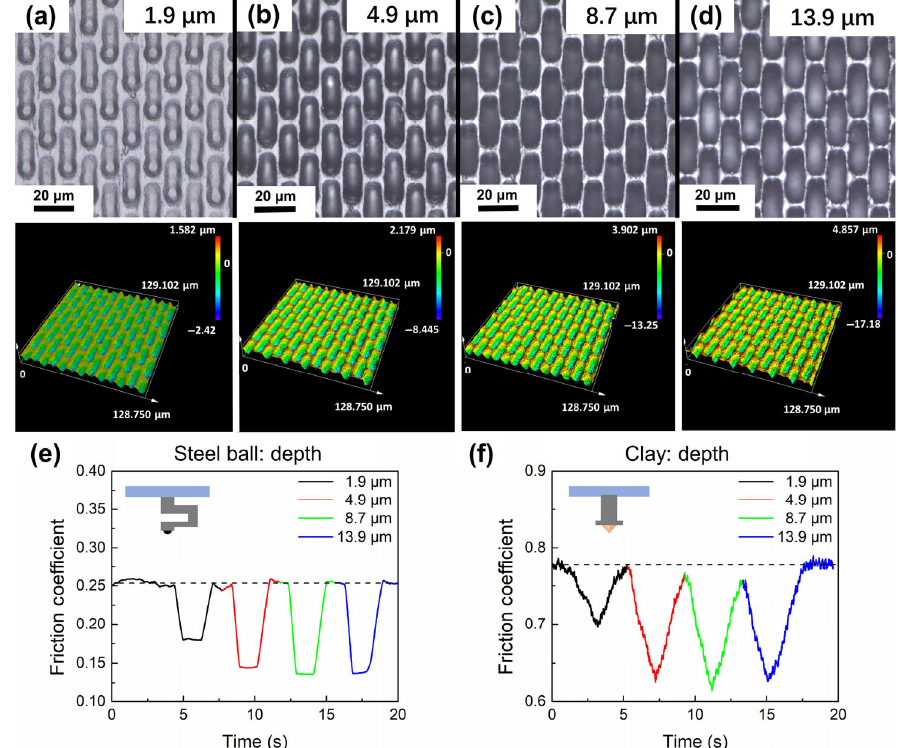
Fig. 6 (a–d) LEXT images of AITPS with the depth of microgrooves increased in different degrees (1.9, 4.9, 8.7, and 13.9 μ m); (e, f) frictional measurement results of AITPS with different depths in contact with steel ball and commercial clay, respectively, with the minimum value of the friction coefficients tended to reduce first and then became